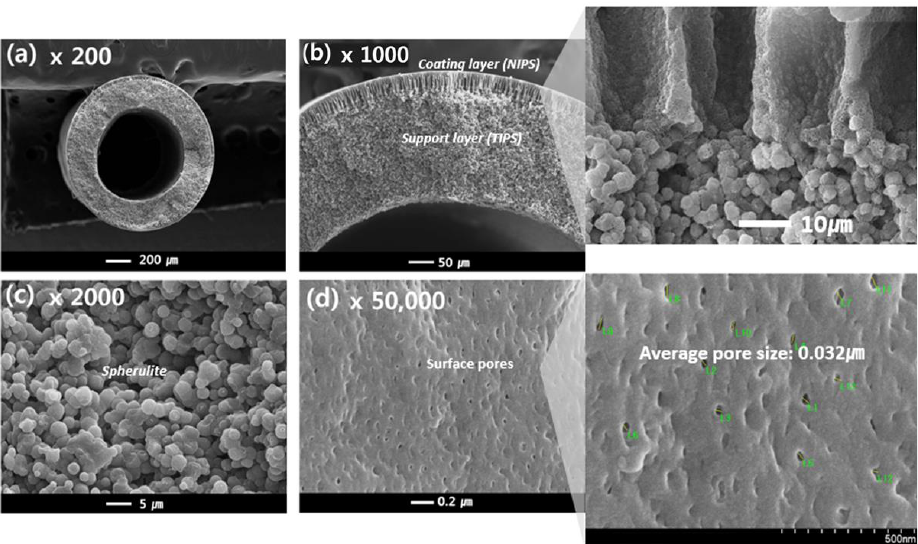
Figure 8. The morphology of the PVDF dual-layer hollow fiber membrane: Cross-sectional image: ( a ) 200×, ( b ) 1000× (highlight 1800×), ( c ) 2000×, and Surface image: ( d ) 50,000× (highlight 70,000×) at magnification; Hollow fiber spinning conditions: Sample #2, TIPS = 17 g/min, NIPS = 7 g/min, Bore = 6 g/min.